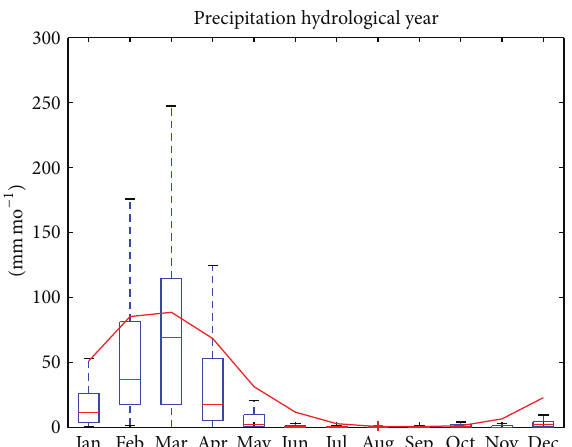
Figure 2: Annual hydrologic cycle corresponding to the monthly mean precipitation (red solid line) in the period 1965–2008. See text for further